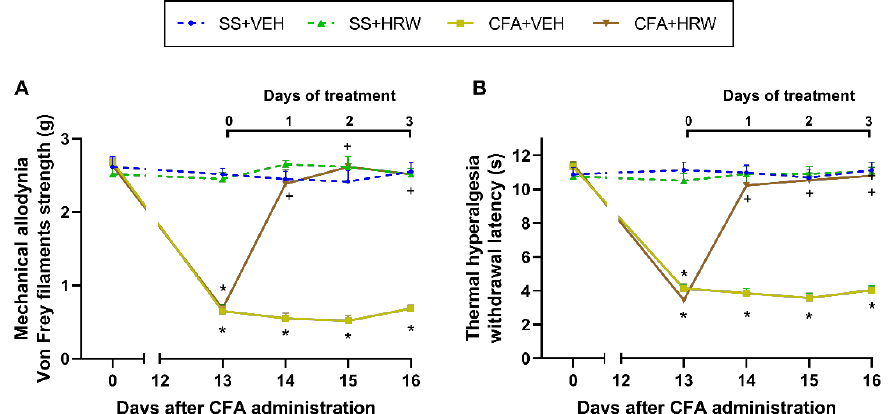
Figure 2. Effects of the subplantar administration of HRW or VEH on the mechanical allodynia and thermal hyperalgesia generated by paw inflammation. Effects of the subplantar administration of HRW or VEH, injected at 2T per day, over the decreased von Frey filaments strength (g) ( A ) and withdrawal latency (s) ( B ) provoked by CFA in the ipsilateral hind paws. For each test, * indicates significant variations vs. SS-injected mice treated with VEH (SS + VEH), and + represents significant differences vs. CFA-injected mice treated with VEH (CFA + VEH) ( p < 0.05, one-way ANOVA and Student–Newman–Keuls test). Data are shown as mean values ± SEM; n = 6 animals for group.